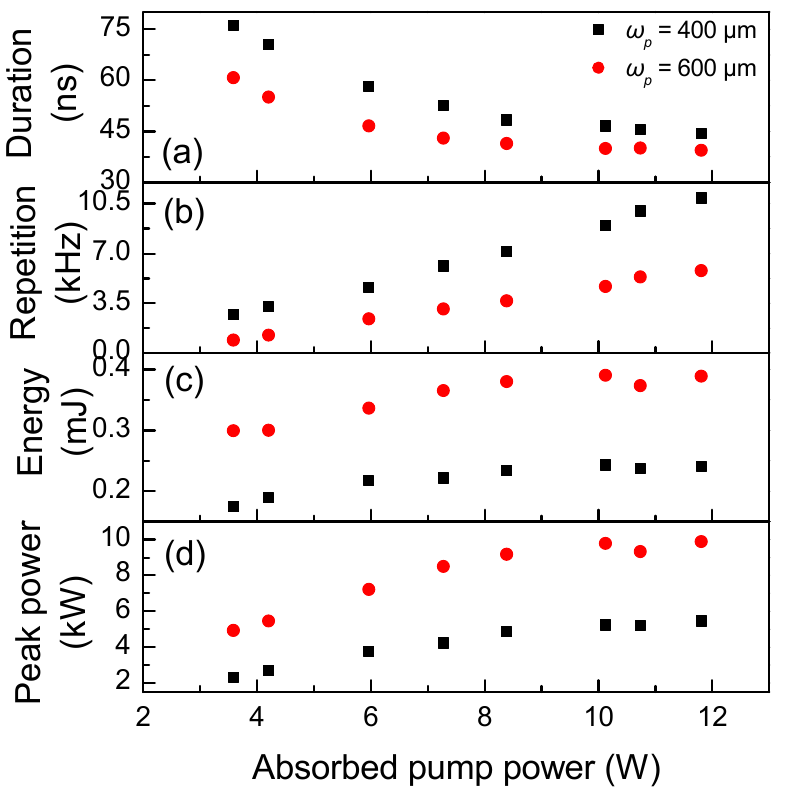
Figure 6. Pulse characteristics of the PQS laser ( T oc = 0.25), ( a ) duration, ( b ) repetition, ( c ) energy, and ( d ) peak power.